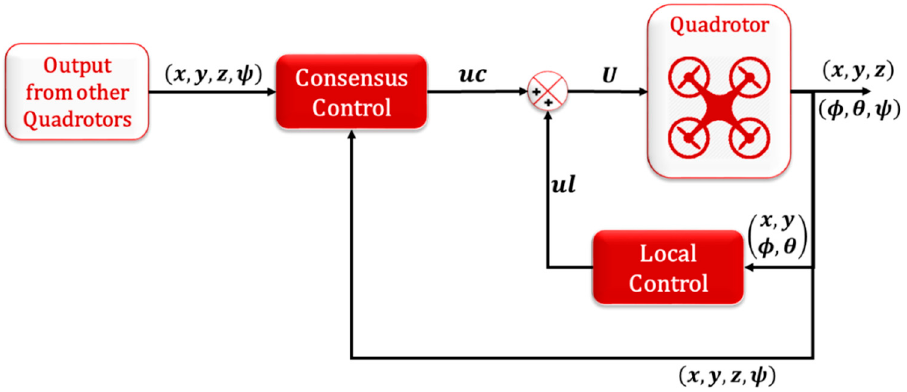
Figure 5. Local and consensus